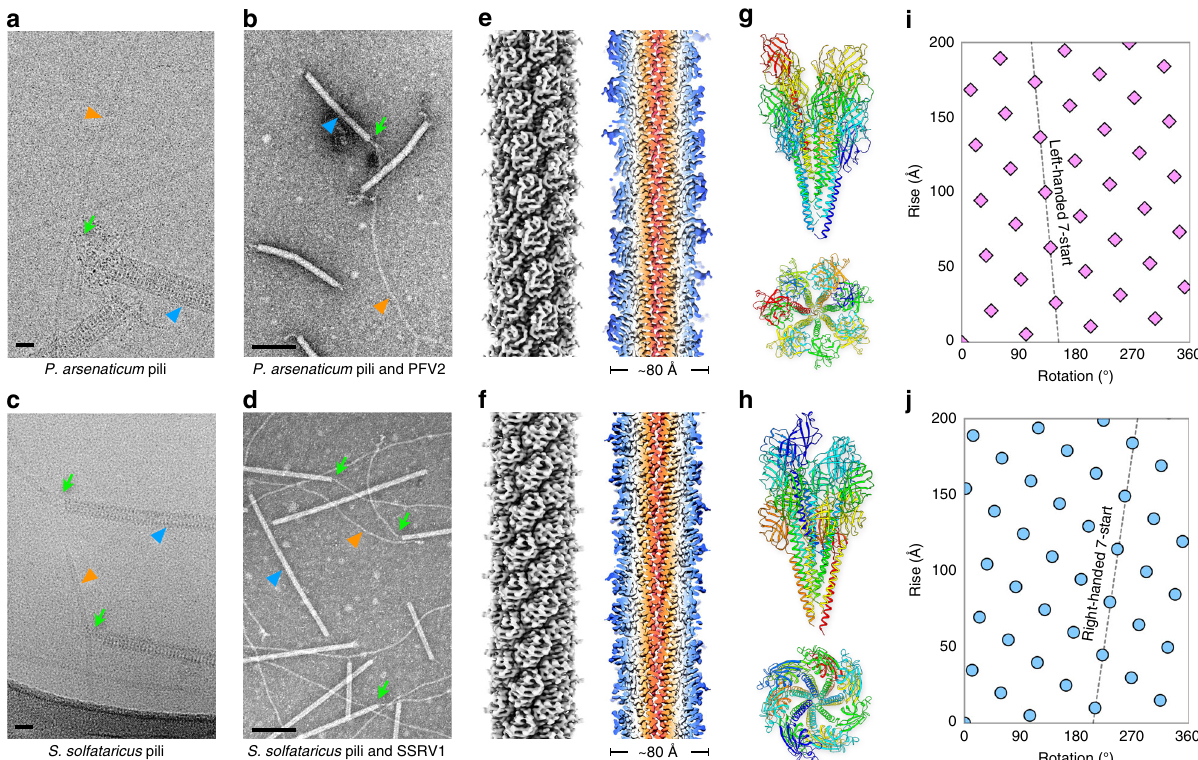
Fig. 1 Cryo-EM of the P. arsenaticum pilus and the S. solfataricus pilus. Representative cryo-electron ( a ) and negative staining ( b ) micrographs of the P. arsenaticum pili interacting with fi lamentous virus PFV2. Scale bar, 20 nm in a and 200 nm in b . Orange arrowhead points to the P. arsenaticum pilus; blue arrowhead points to the PFV2 virion; green arrow points to the regions of the pilus-virion interaction. Representative cryo-electron ( c ) and negative staining ( d ) micrographs of the S. solfataricus pili interacted with fi lamentous virus SSRV1. Scale bar, 20 nm in c and 200 nm in d . Orange arrowhead points to the S. solfataricus pilus; blue arrowhead points to the SSRV1 virion; green arrow points to the regions of the pilus-virion interaction. Cryo-EM reconstruction of the P. arsenaticum pilus at 3.8 Å resolution ( e ) and the S. solfataricus pilus at 3.4 Å resolution ( f ). Thin slices parallel to the helical axis of the pilus are shown, colored by the helical radius. g , h Side view and top view of the P. arsenaticum and S. solfataricus pilus atomic models, built into the cryo-EM maps shown in e , f . The model is colored by chain. Helical net of the pilus ( P. arsenaticum pilus in i and the S. solfataricus pilus in j ) using the convention that the surface is unrolled and we are viewing from the